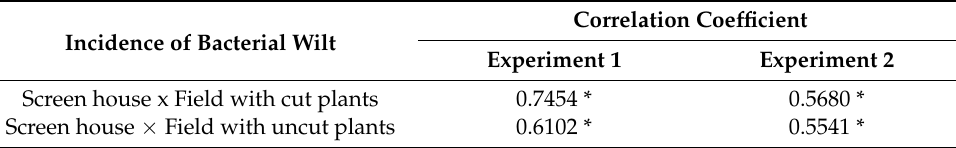
Table 9. Correlation coefficient between the incidence of bacterial wilt in screen house and field